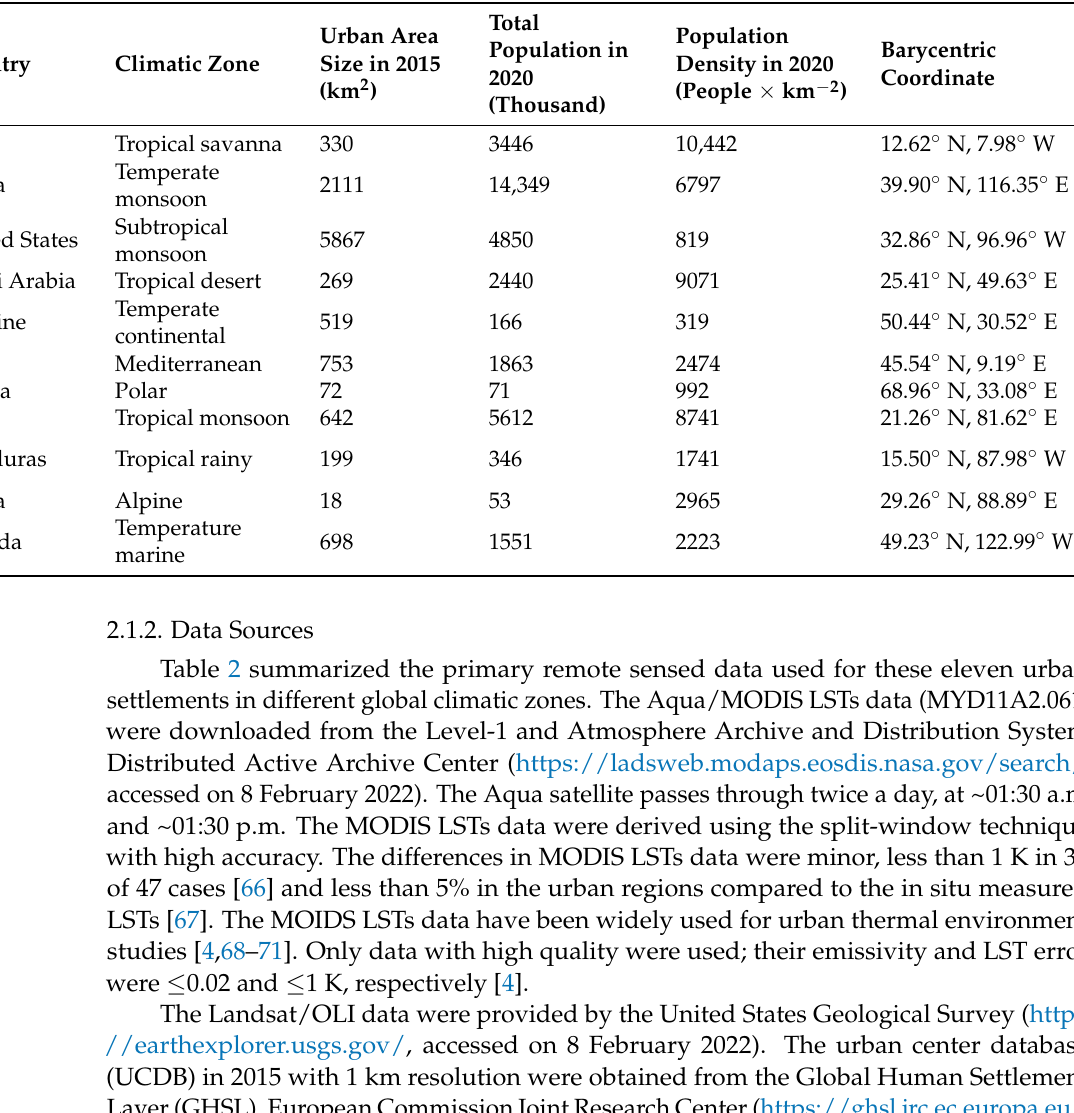
Table 1. Basic information for the eleven selected urban